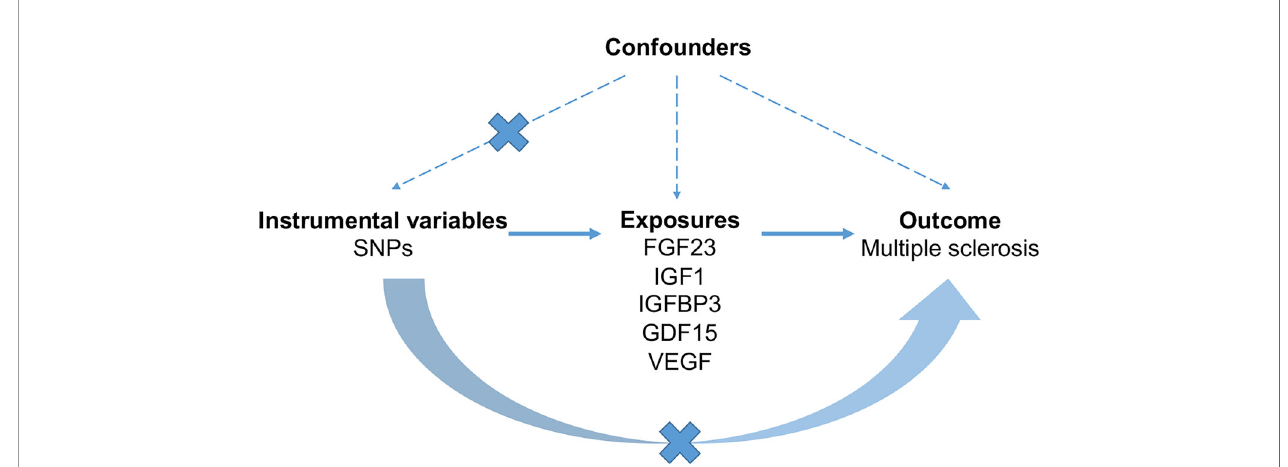
FIGURE 1 | The schematic diagram demonstrating concept of the MR design. Three key assumptions underlay standard selection procedure of instrumental SNPs. First, selected SNPs were robustly associated ( p < 5 × 10 -8 ) with exposures of interest. Second, later-life confounders of the exposure-outcome link scarcely existed, given that genetic variants were inherited at gamete formation when randomized allocation of instrumental variant alleles among the large population were determined. Thirdly, the exclusion-restriction assumption, that instrumental SNPs affected the outcome only though the exposure, were examined by sensitivity analyses. FGF23, fi broblast growth factor 23; GDF15, growth differentiation factor 15; IGF1, insulin-like growth factor 1; IGFBP3, insulin-like growth factor-binding protein 3; VEGF, vascular endothelial growth factor; MS, multiple sclerosis; SNP, Single-nucleotide